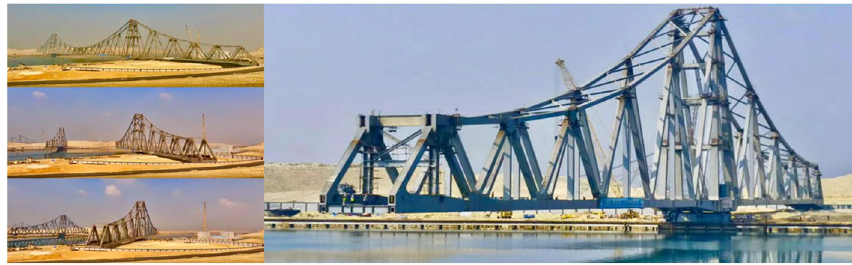
Fig. 6 The New El Felden Railway Open Bridge in